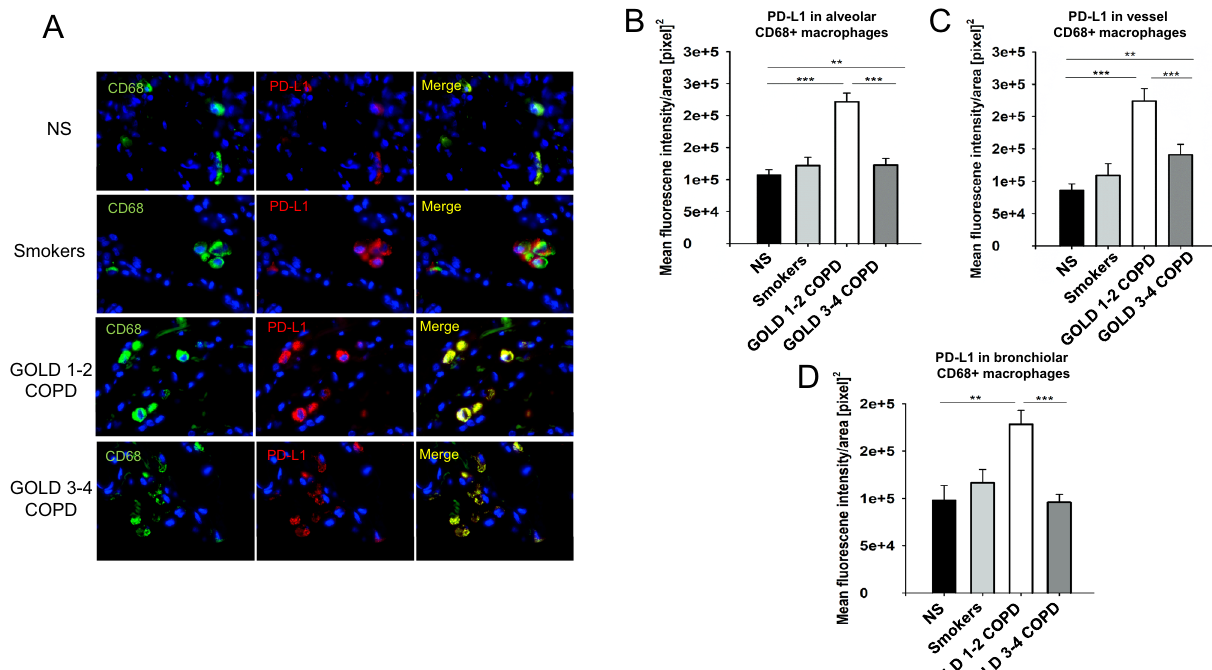
Figure 4. PD-L1 is overexpressed in peripheral lung AMs from GOLD 1–2 COPD patients: Immunofluorescence analysis of PD-L1 expression in CD68 + AMs in peripheral lungs from Cohort 1. ( A ) representative immunofluorescence pictures showing CD68+ (green, as a marker of macrophages) and PD-L1+ (red) cells. Nuclear DNA was labeled with DAPI (blue). ( B ) Mean fluorescence intensity of PD-L1 in alveoli from never-smokers (NS), smokers without COPD, GOLD 1–2 and 3–4 COPD patients. ( C ) mean fluorescence intensity of PD-L1 in vessels from never-smokers (NS), smokers without COPD, GOLD 1–2 and 3–4 COPD patients. ( D ) Mean fluorescence intensity of PD-L1 in bronchioles from never-smokers (NS), smokers without COPD, GOLD 1–2 and 3–4 COPD patients. * P < 0.05, ** P < 0.01, *** P <